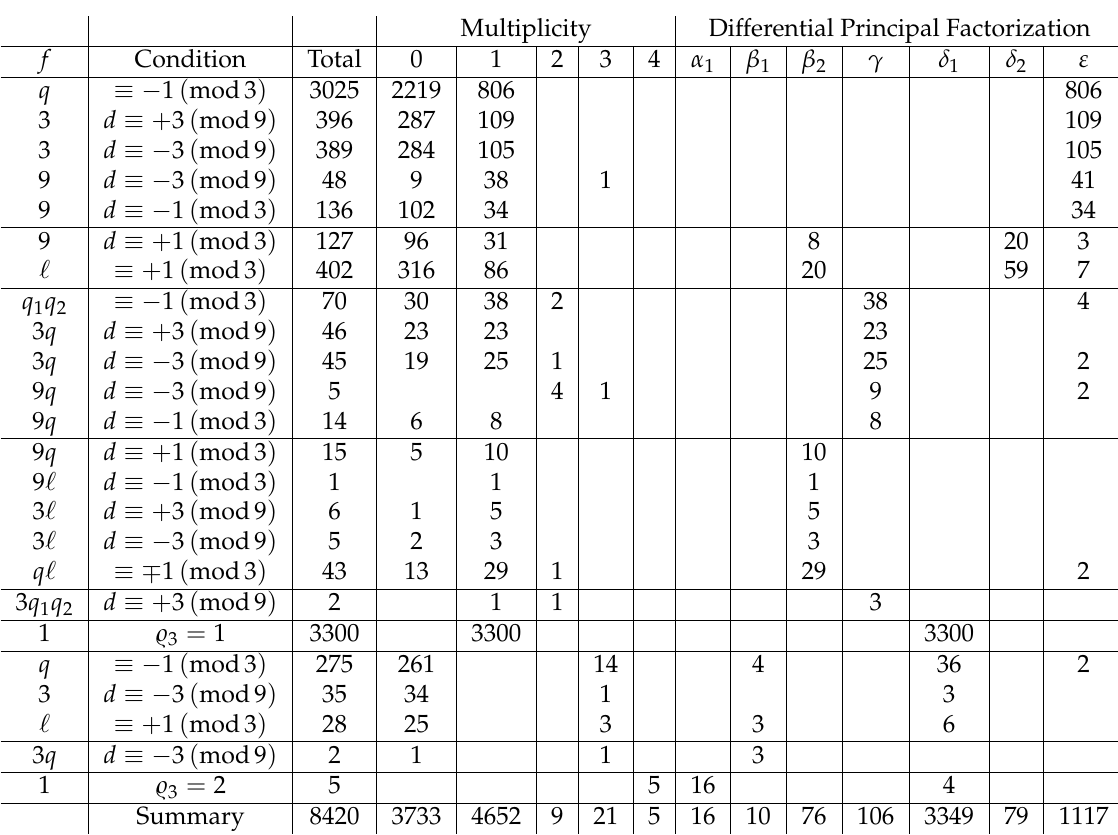
Table 3. Cubic discriminants in the range 0 < d L = f 2 · d < 10 5